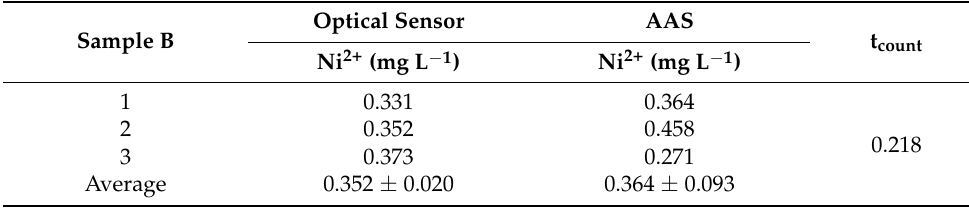
Table 3. Comparison of the detection